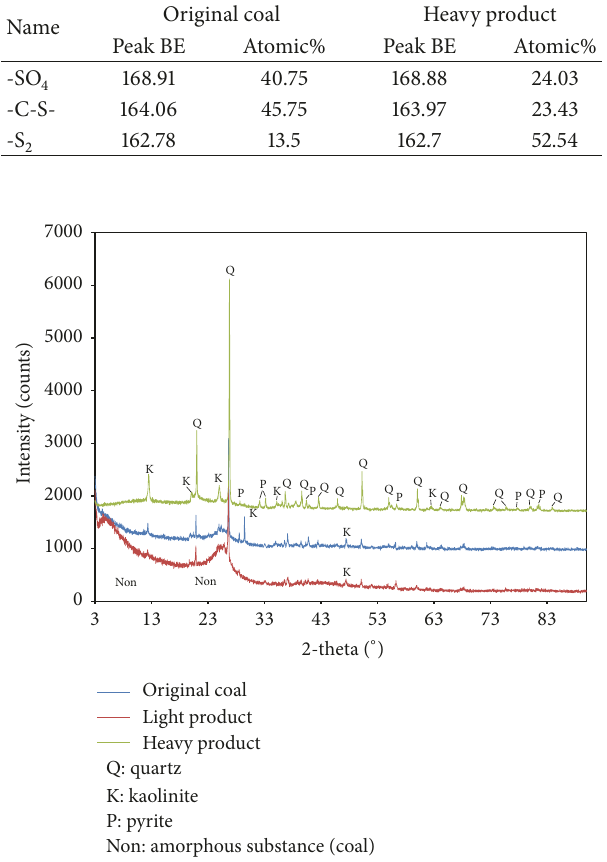
Figure 5: X-ray diffraction of the different